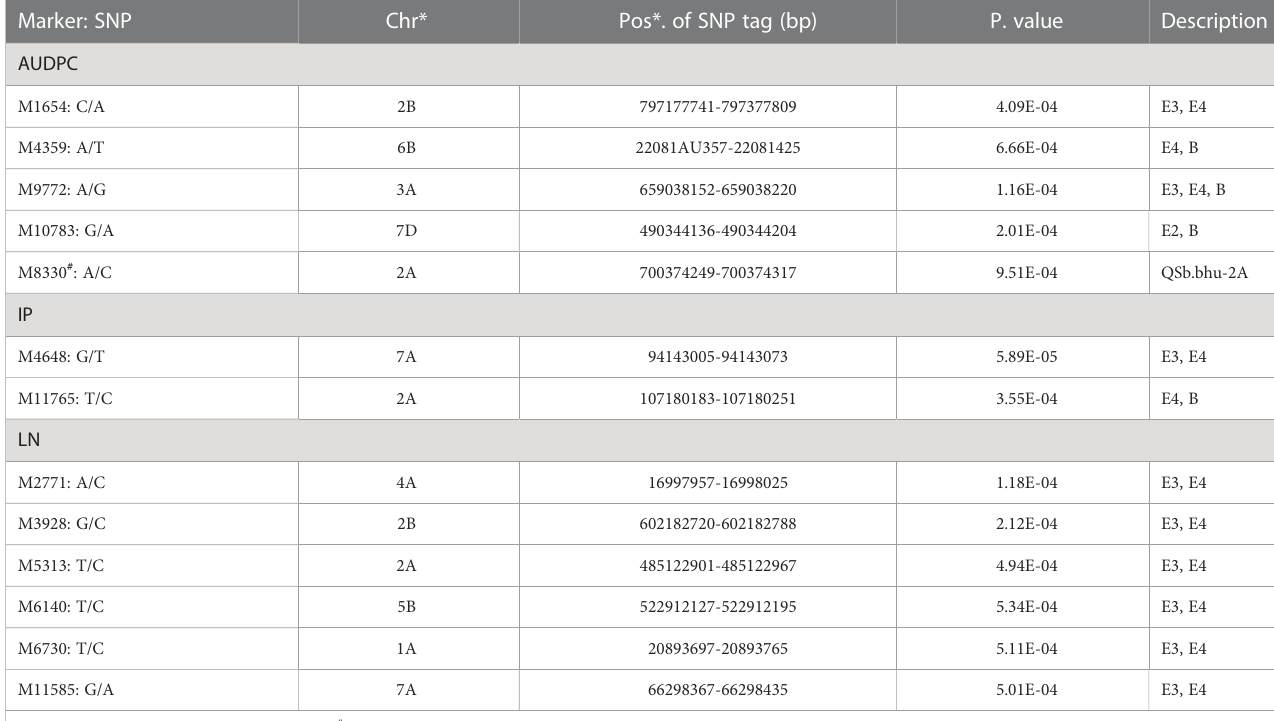
TABLE 4 A summary of most important MTAs common in four GWAS models (CMLM, MLMM, FarmCPU & BLINK; MTAs with SUPER not